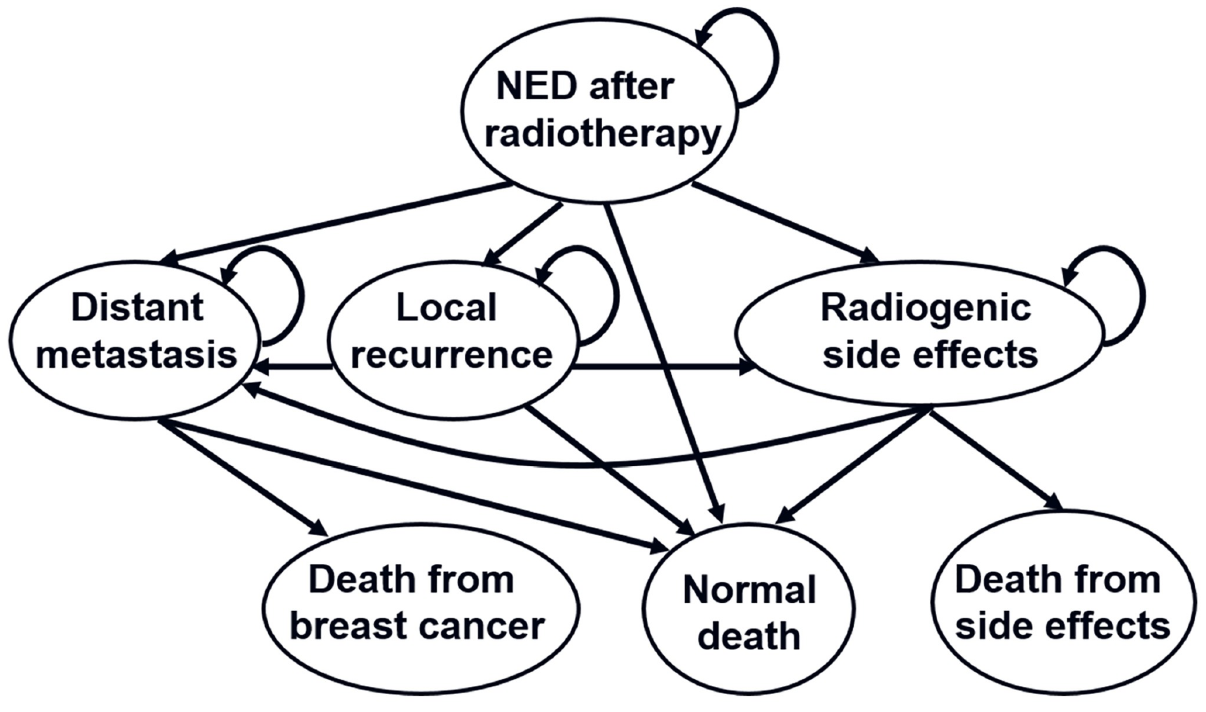
Fig 1. Overview of the Markov model. NED = no evidence of